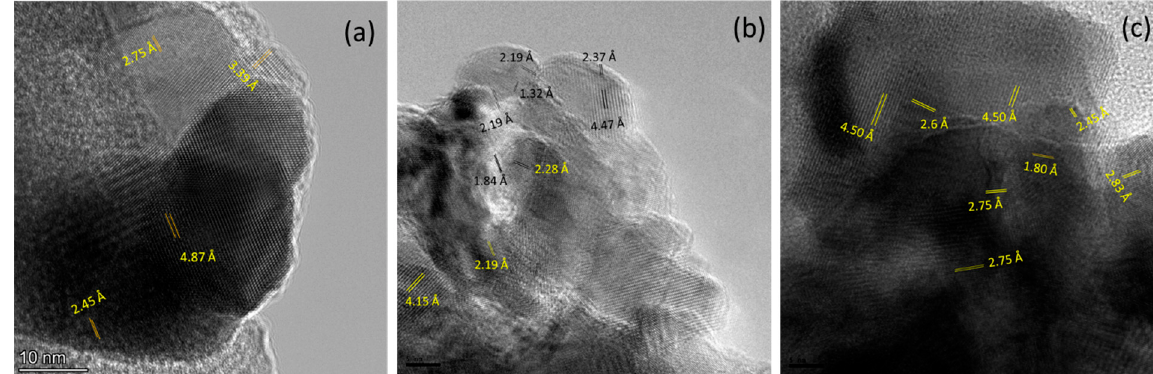
Figure 8. High-Resolution TEM Images of ( a ) OMO(5) and ( b , c ) OMO(40) showing the presence of CoO, Co 3 O 4, and Co phases.